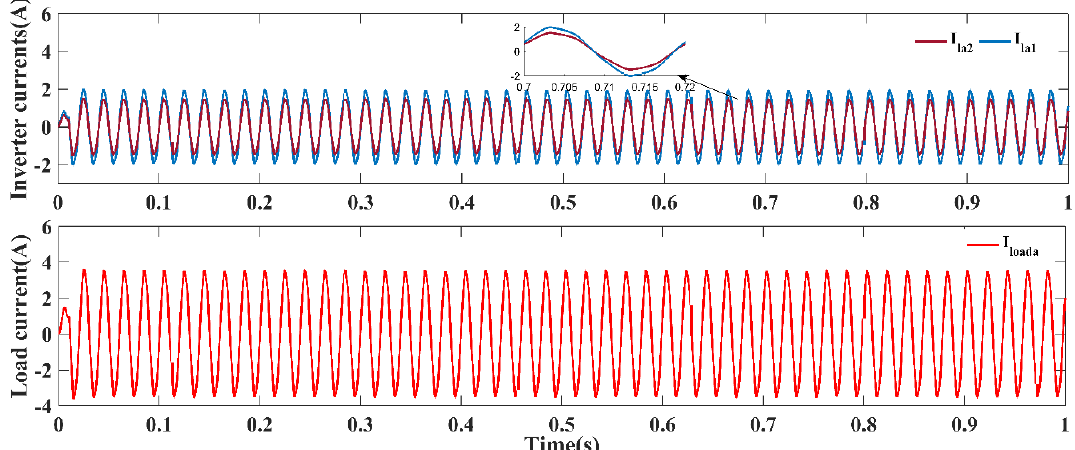
Figure 9. Current sharing during conventional droop control.